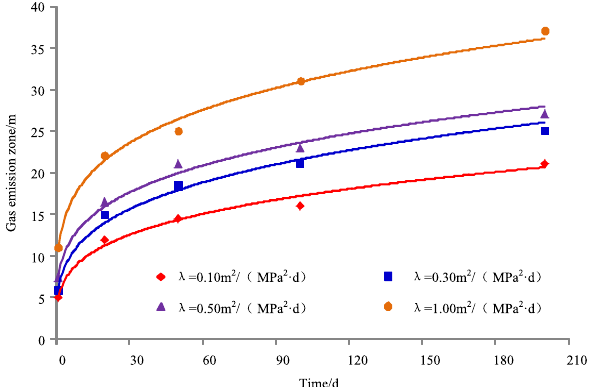
Figure 7. Variation of gas emission zone size with time under different permeability coefficients.